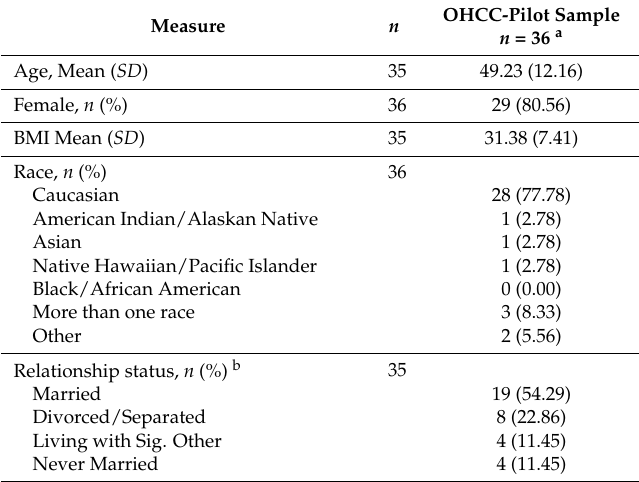
Table 2. Home care worker participants in the pilot study of the COMPASS adaptation for the Oregon Home Care Commission: Characteristics at